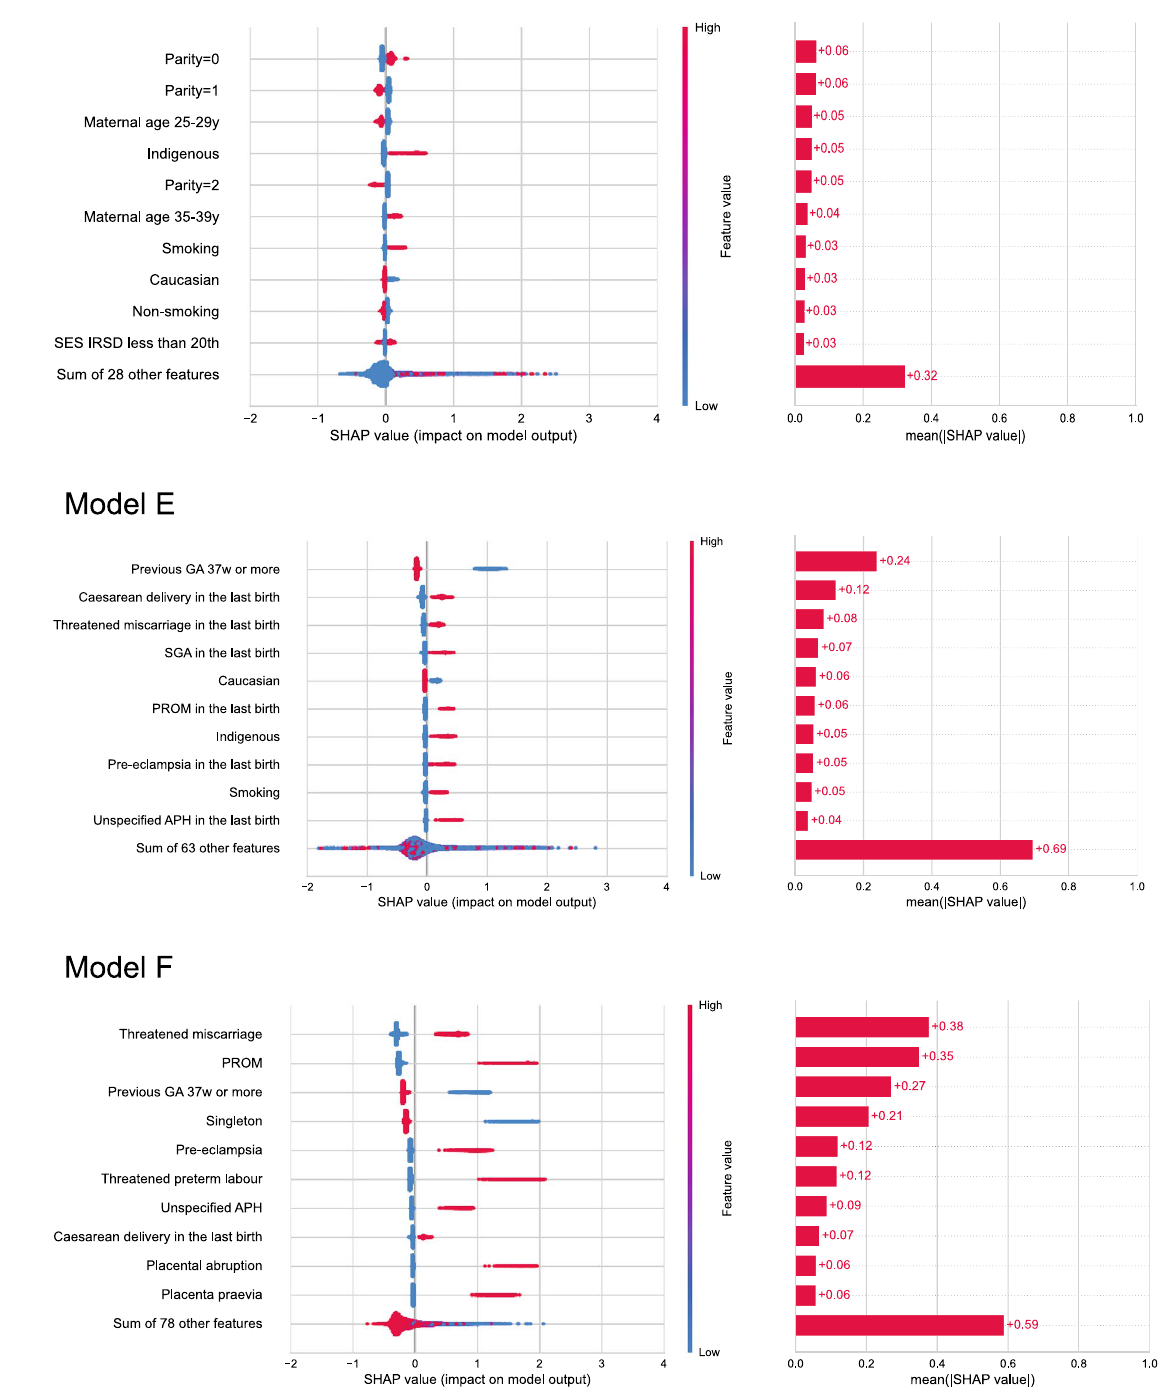
Figure 6. Summary plot of the SHapley Additive exPlanations (SHAP) value for models ( D ), ( E ) and ( F ) developed using the XGBoost classifier. The “beeswarm” plot on the left shows the distribution of the SHAP value (in log-odds scale) calculated using the test dataset. Each dot represents a prediction result of a particular feature for a particular individual. The colour of the dots shows the feature values (red = present/1, blue = absent/0). A positive SHAP value means the predictor increases the likelihood of preterm birth, and a negative value means otherwise. The bar graph on the right side shows the mean absolute SHAP value for each feature. The feature names are displayed on the far left in order of the mean absolute value. y, years; SES, socio- economic status; IRSD, The Index of Relative Socio-economic Disadvantage; GA, gestational age; w, weeks; SGA, small for gestational age; PROM, pre-labour rupture of membrane; APH, antepartum